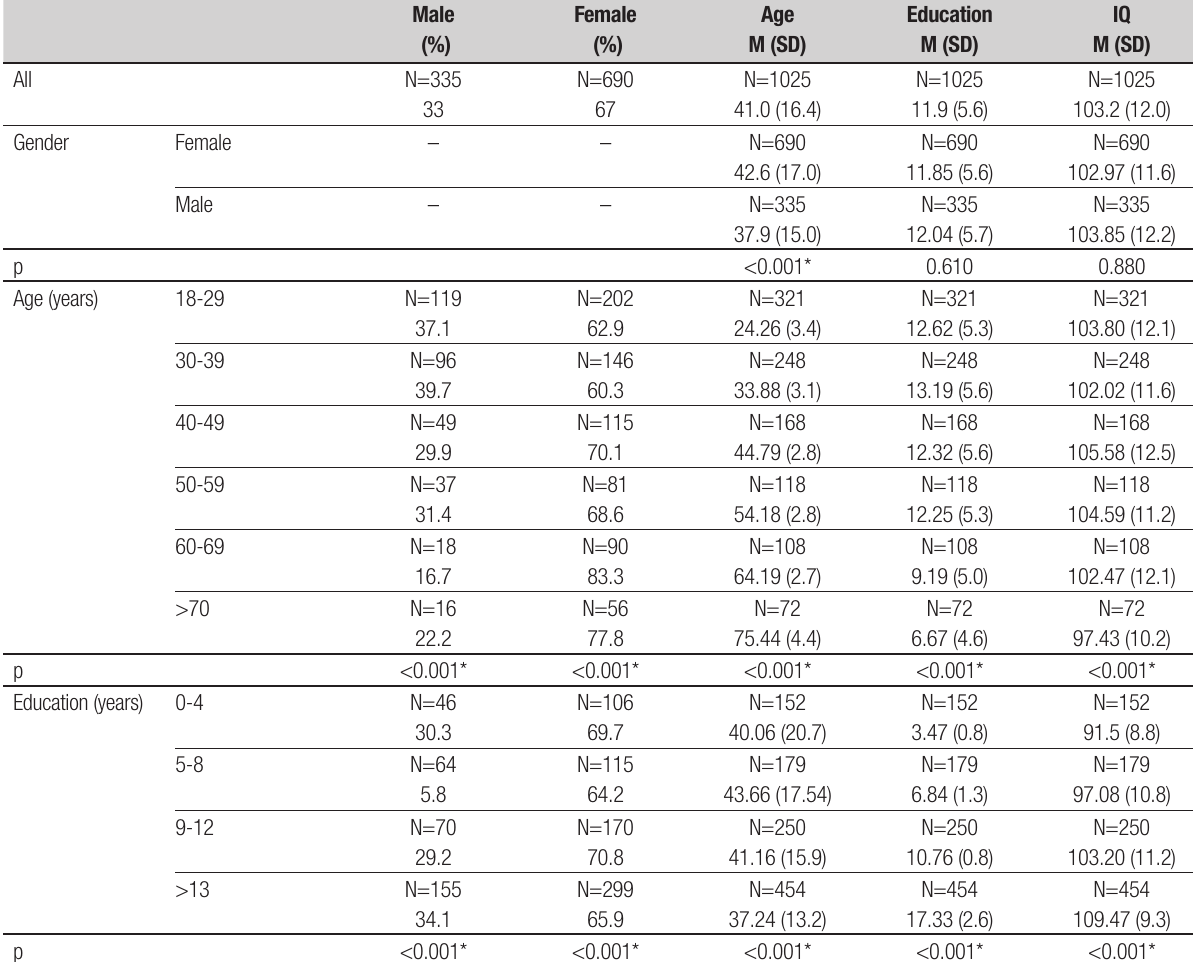
Table 1. Mean, standard deviation, absolute and relative frequency of sociodemographic data and IQ for all participants and for gender, age and education